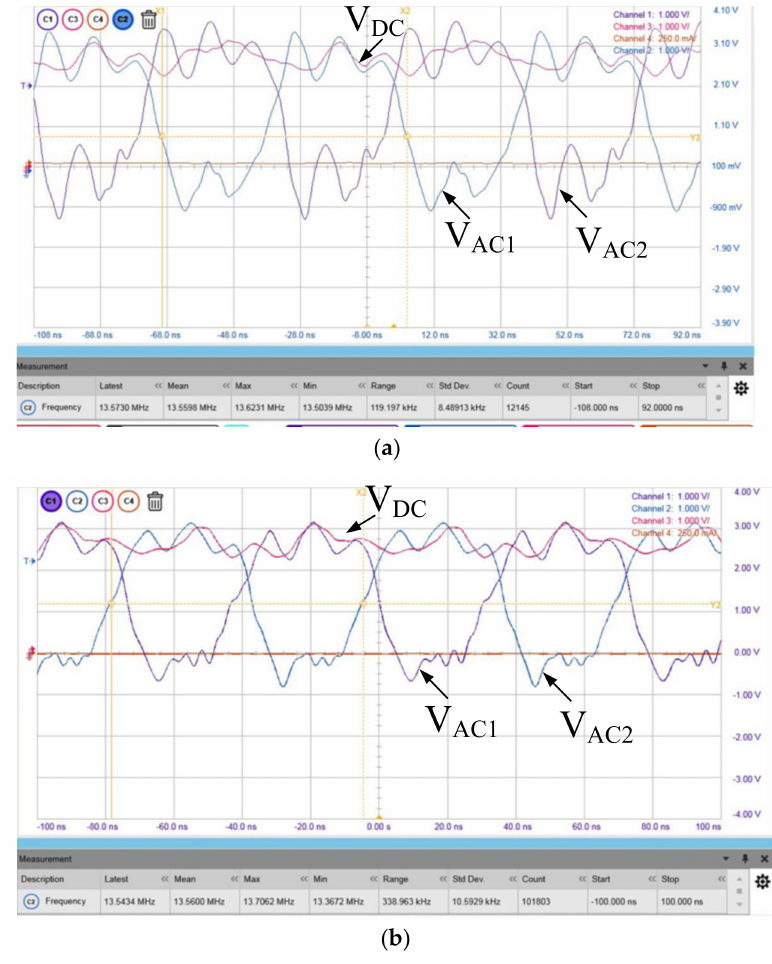
Figure 13. Measured waveforms of the proposed rectifier ( a ) without phase error detector and ( b ) with phase error detector.